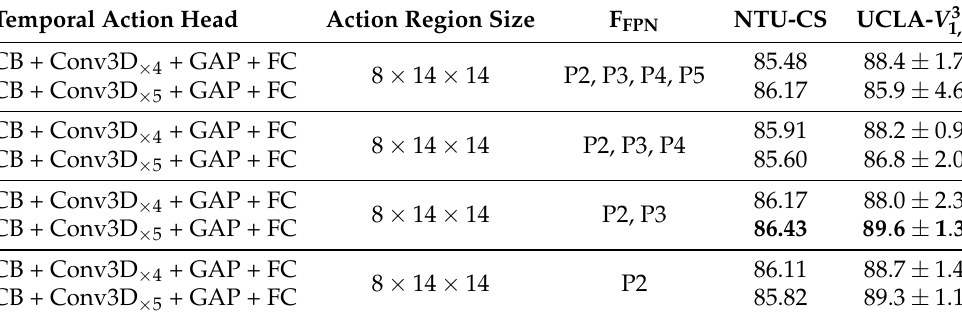
Table 6. Experimental results according to the combination of FPN features.